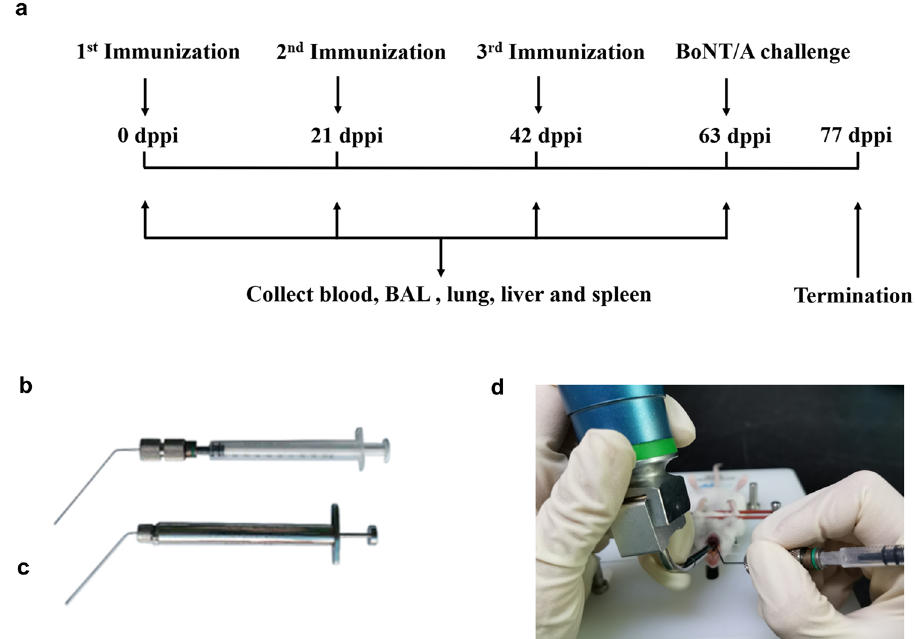
Fig. 2 Schematic of immunization via intratracheal inoculation method. a The immunization scheme, b powder MicroSprayer Aerosolizer (Huironghe Company, Beijing, China), and c liquid MicroSprayer Aerosolizer (Huironghe Company, Beijing, China) used for i.t. inoculation. d Representative image of non-invasive i.t. powder inoculation. Anesthetized mice were placed on a slanted board. The trachea was exposed using a laryngoscope, the MicroSprayer Aerosolizer was inserted 25 mm from the larynx, and the powder was sprayed. BAL bronchoalveolar lavage, dppi days post primary group (Fig. 4e), while the survival percentage of the i.t.-AHc (liquid)-